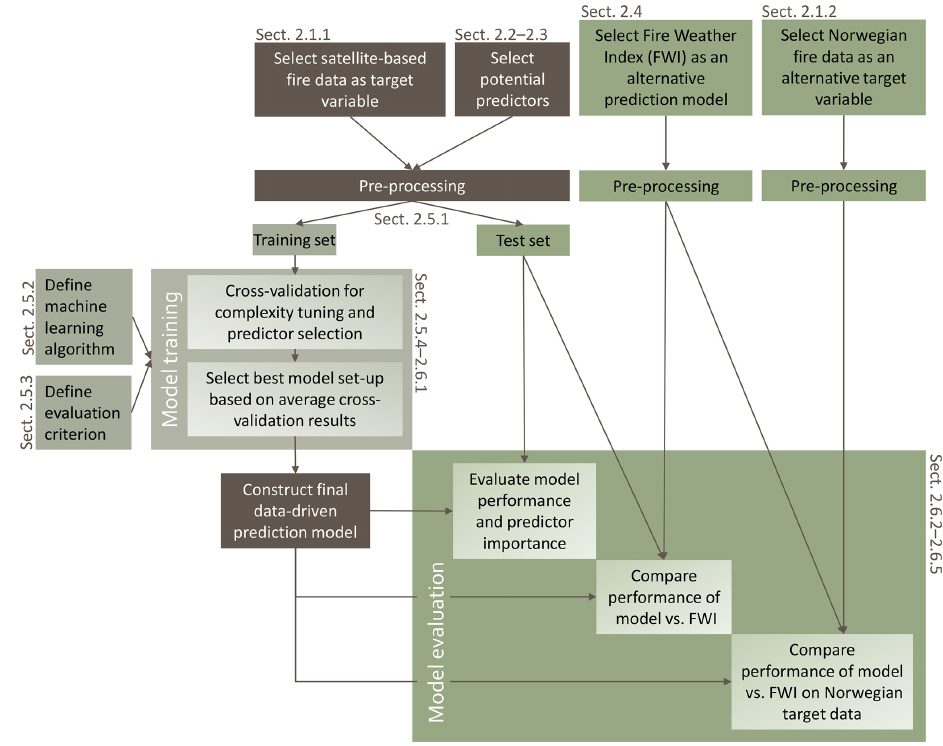
Figure 1. Flow chart of the data-driven approach for Fennoscandia. Sections given in the flow chart refer to sections in the text where detailed descriptions can be found. Grey, green and dark brown boxes represent steps relevant to model training, model evaluation and both, respectively.